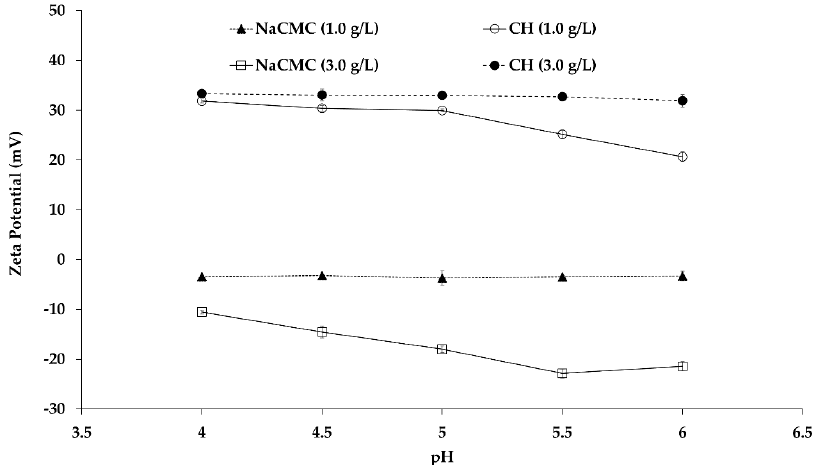
Figure 1. Zeta potential values of aqueous chitosan (CH) and carboxymethyl cellulose sodium salt (NaCMC) at different pH. Mean values with 95% confidence interval.